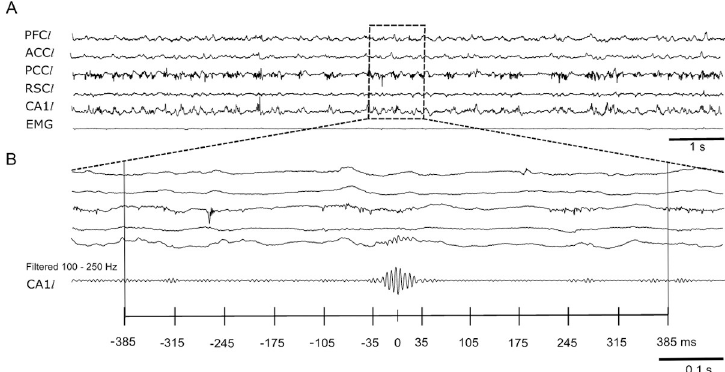
Fig 1. Representative example of an epoch containing SWR. (A) Simultaneous recordings of LFPs from left prefrontal cortex (PFC l ), left anterior cingulate cortex (ACC l ), left post cingulate cortex (PCC l ), left retrosplenial cortex (RSC l ), left dorsal hippocampus CA1 (CA1 l ), and an electromyogram of the neck muscle (EMG) during SWS (B) Enlargement of 1 sec recordings of the LFPs showing SWR oscillation within a 770 ms epoch in raw and filtered data. Notice a single SWR centered in the middle window and no other SWRs occurring before or after it (bottom panel).